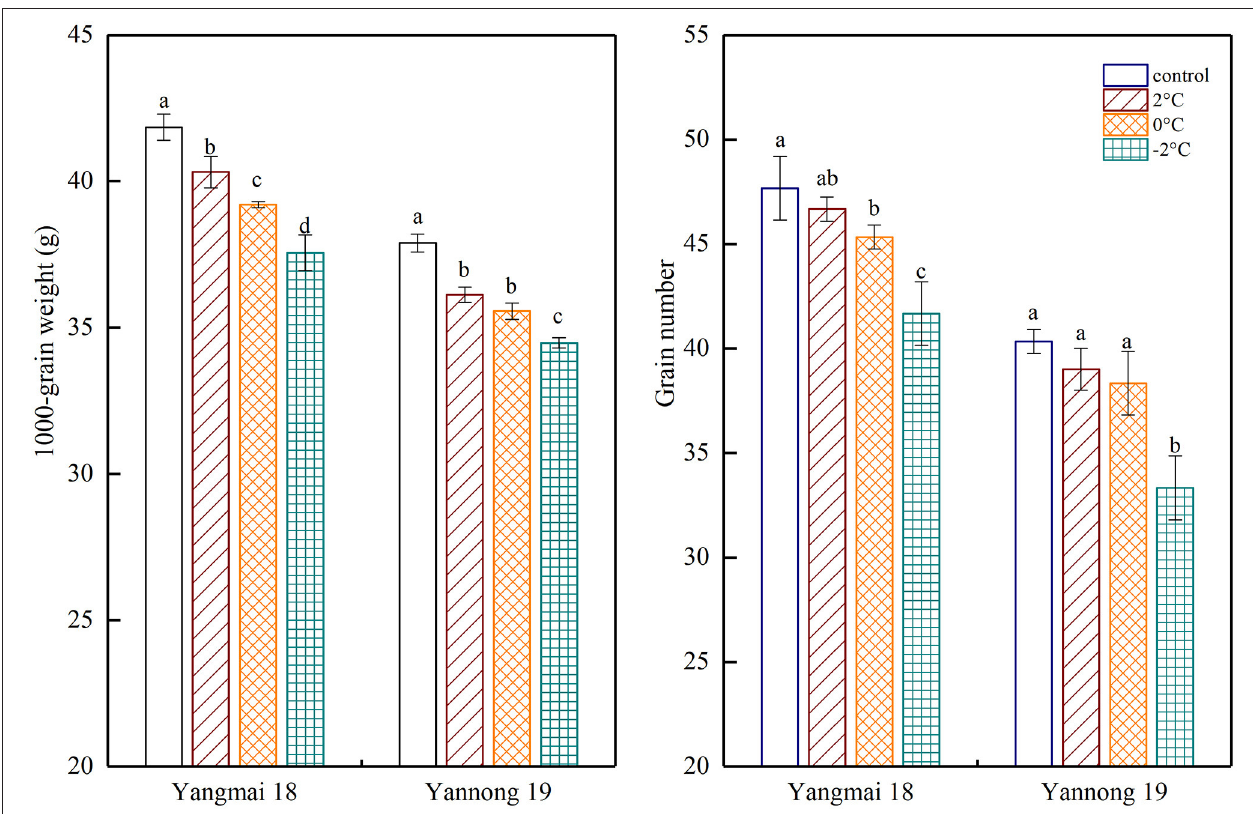
FIGURE 8 | The effect of short-term LT at the booting stage on the 1000-grain weight and the grain number. At the booting stage, wheat plants were placed in an artificial climate chamber for LT stress. The temperature was set to 5 ◦ C during 07:00–19:00 and 2, 0, and − 2 ◦ C during 19:00–07:00. The normal growing plants without cold stress were used as controls. The data are presented as the means ± SD ( n = 3). Different lowercase letters indicate significant differences between the treatments determined using the Duncan’s multiple range test ( P <